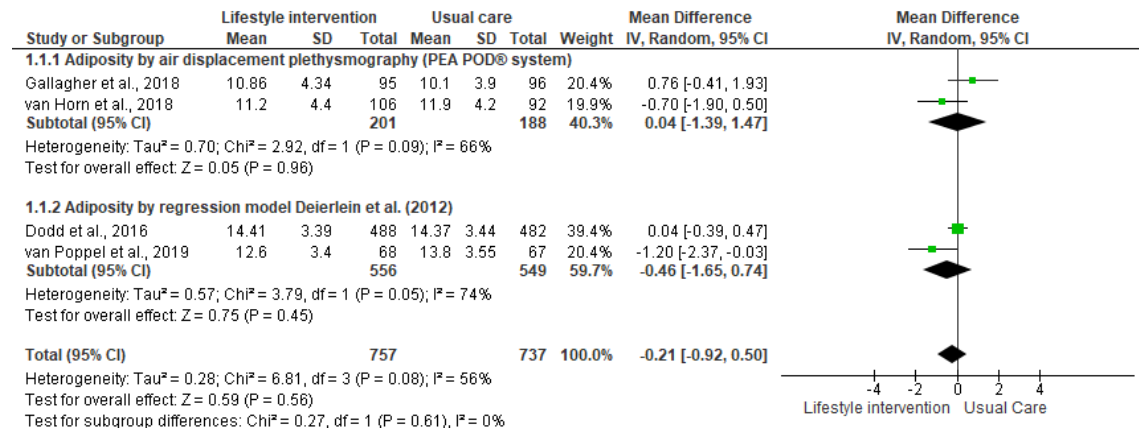
Figure 3. Effect of the lifestyle interventions in pregnant women with excessive body weight on neonatal adiposity according to the assessment method [38–41]. SD = standard deviation; CI = confidence interval; Tau 2 = Tau-squared test; Chi 2 = Chi-squared test; Df = difference; P = p value; I 2 = heterogeneity; Z = Z test.